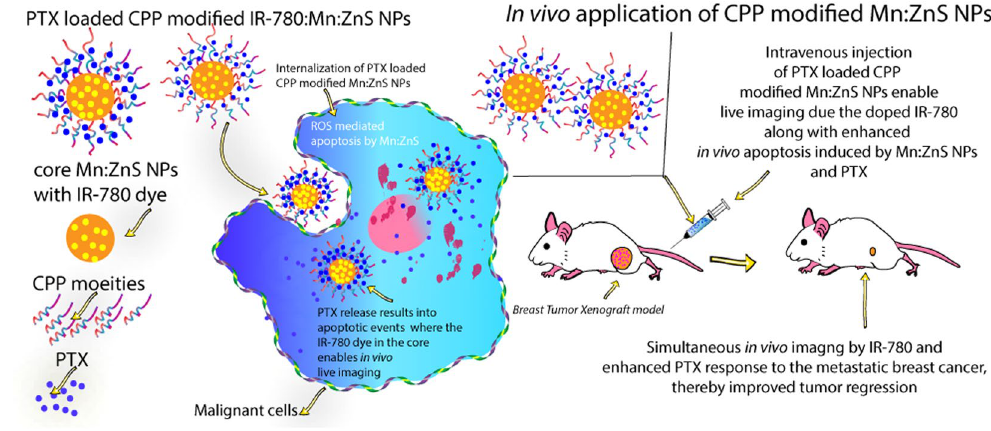
Figure 1. Research strategy for the CPP modified PTX loaded Mn:ZnS NPs for anti-cancer therapy. The Mn:ZnS NPs are doped with IR-780 dye in its core which can ensure enhanced in vivo live imaging, where the outer surface is coated with CPPs to improve the serum stability, and cell localization capability. The PTX molecules are attached with the coated CPPs and can be released in acidic environment where the Mn:ZnS NPs can induce ROS mediated apoptosis improving the PTX effect to the cancer